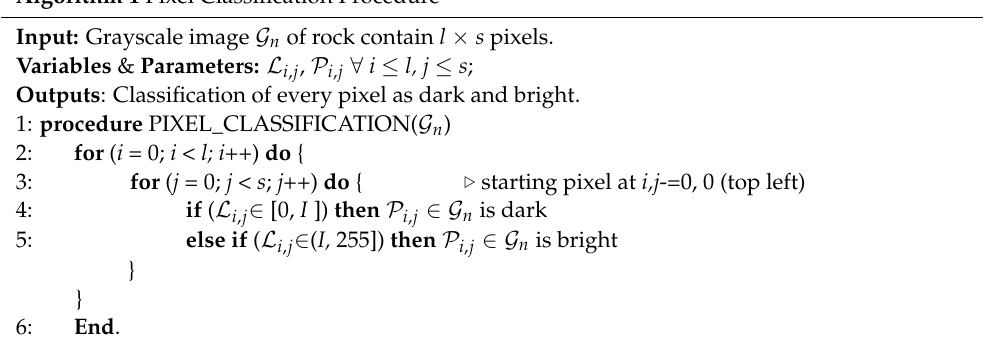
Figure 1. ( a ). Step ‐ wise procedure to find k ‐ INs of any pixels. area ( ℋ 𝑖 ), major ( ℋ 𝑖 ), minor ( ℋ 𝑖 ), pe ‐ rimeter ( ℋ 𝑖 ) and curl ( ℋ 𝑖 ) of a fracture and pore are shown in ( b ) and ( c ), respectively. Quite evi ‐ (cid:2923)(cid:2911)(cid:2920)(cid:2925)(cid:2928)(cid:4666)ℋ (cid:3284) (cid:4667) value of a fracture is larger than that of a dently, the (cid:2923)(cid:2919)(cid:2924)(cid:2925)(cid:2928)(cid:4666)ℋ (cid:3284) (cid:4667)